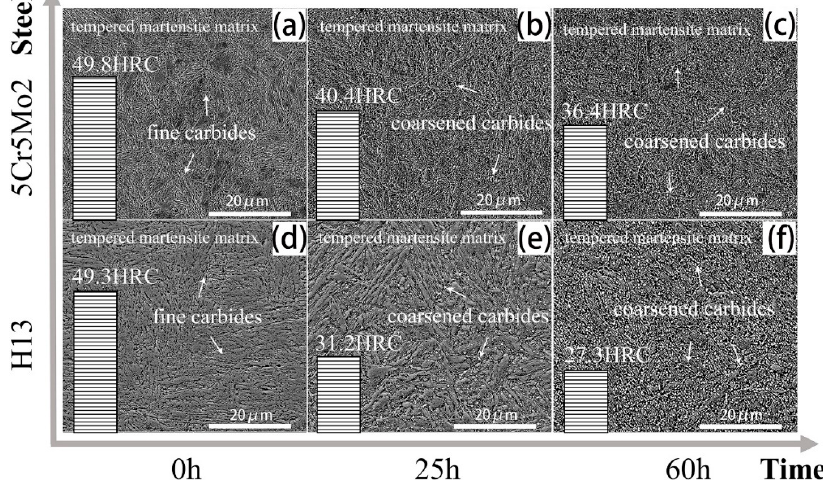
Figure 6. Microstructure and hardness after a tempering lasting (a) 0 h, (b) 25 h, and (c) 60 h for the 5Cr5Mo2 steel; and (d) 0 h, (e) 25 h, (f) 60 h for the H13 steel.